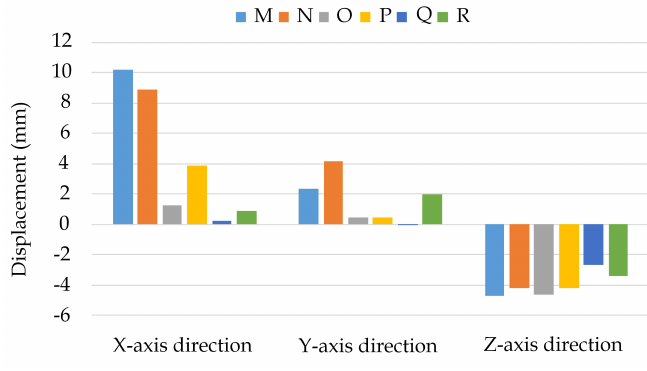
Figure 5. M–R displacement results.